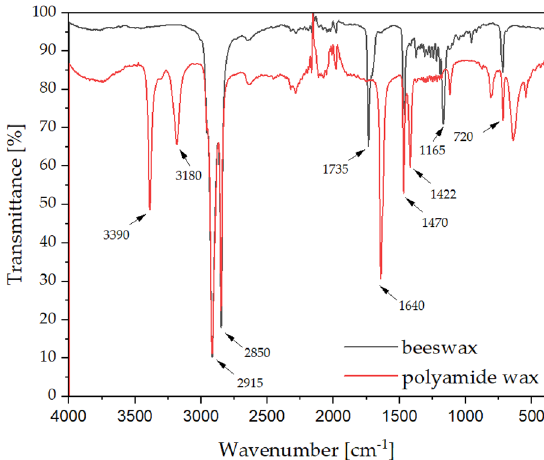
Figure 3. FT-IR spectra of beeswax and polyamide